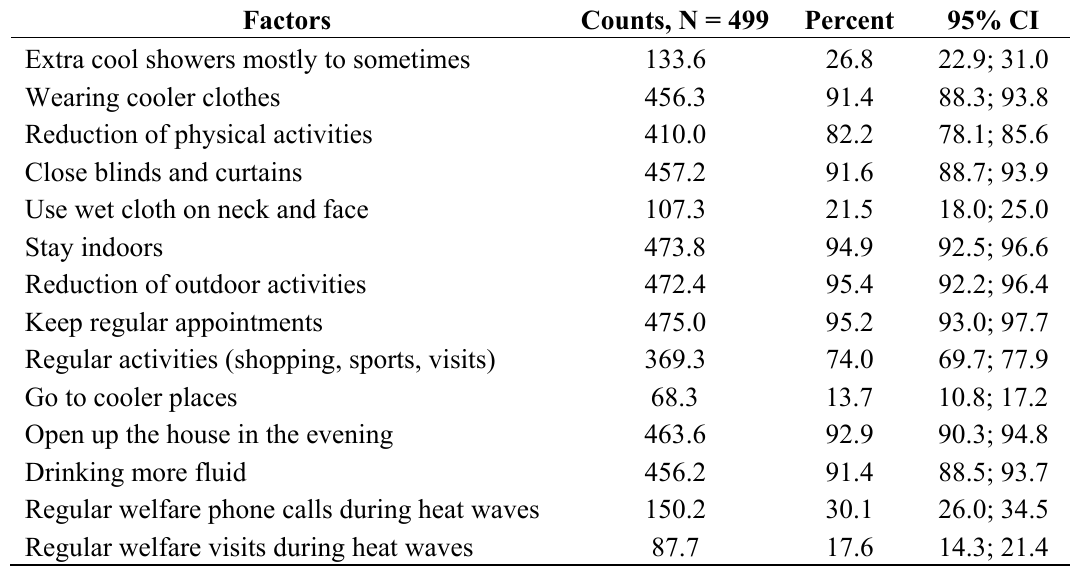
Table 2. Behaviors of older people during extreme heat in SA. Weighted counts, percent and 95%